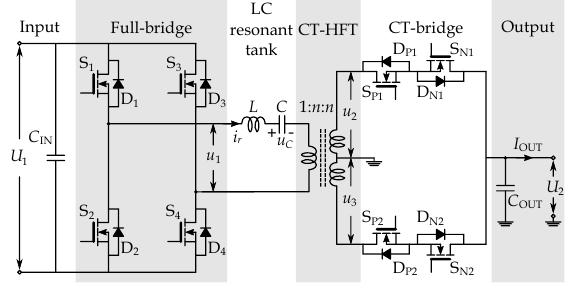
Figure 1. Proposed Converter Schematic.